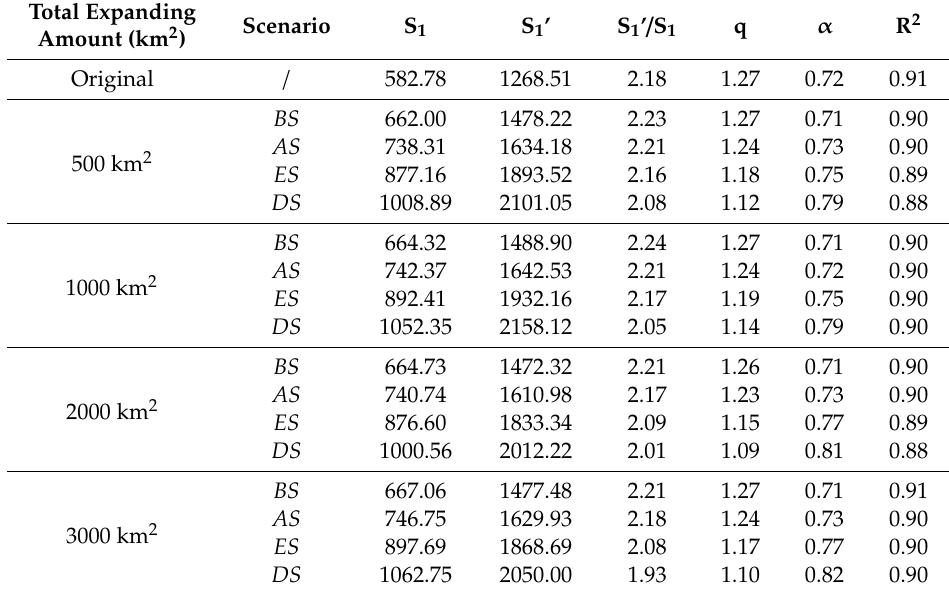
Table 5. Urban rank-size of regional urban system under di ff erent